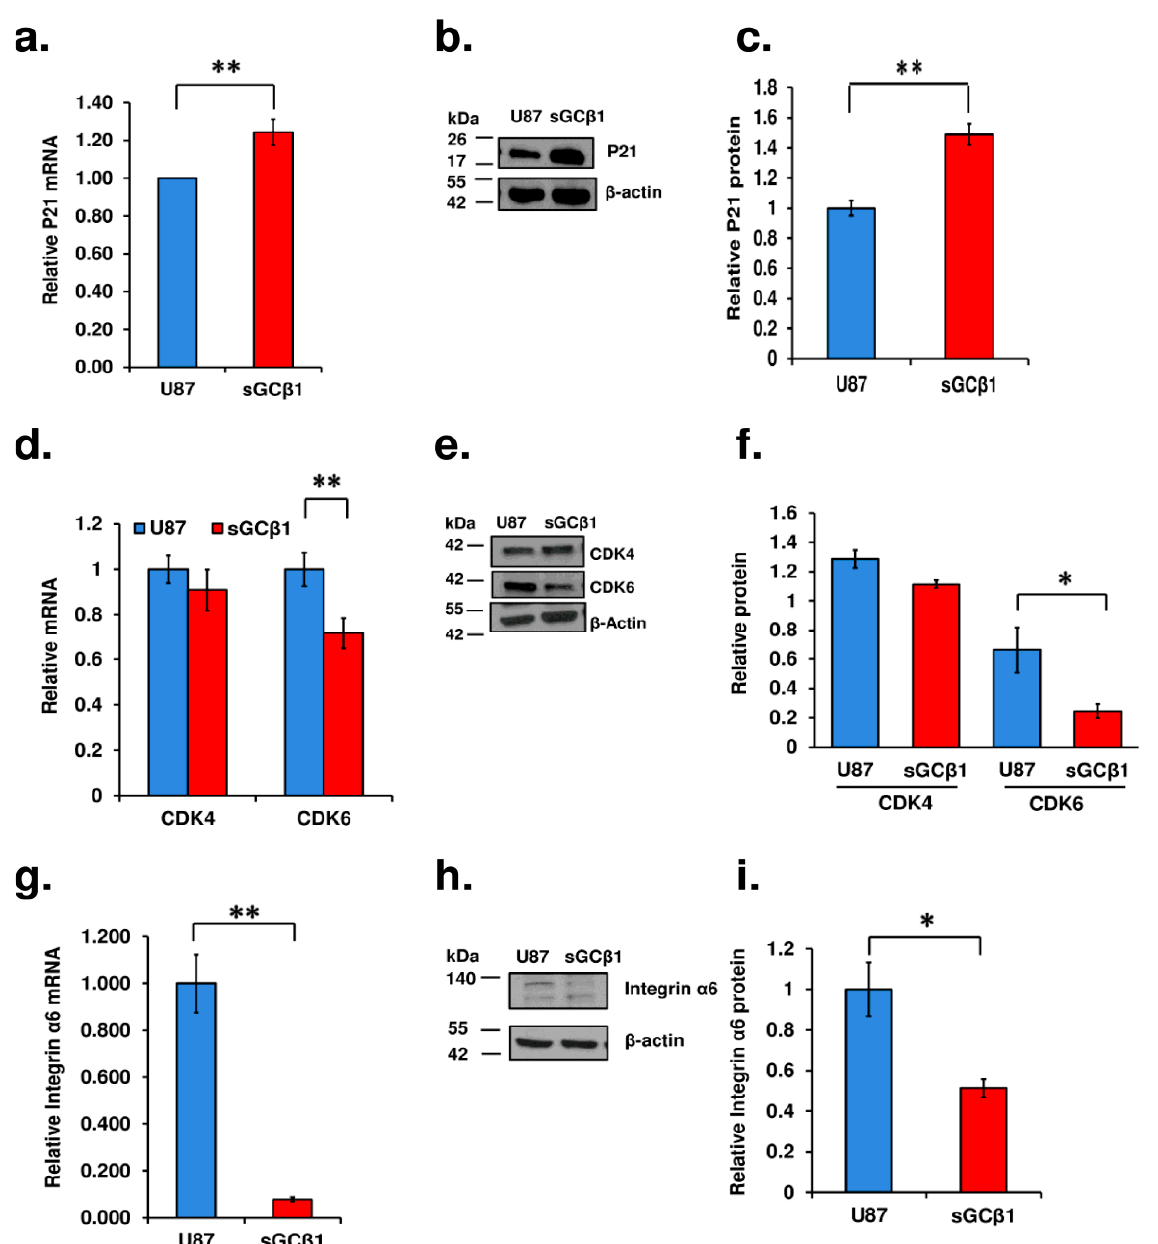
Figure 6. Effects of sGC β 1 overexpression on signaling in glioblastoma multiforme. qRT-PCR analysis of p21 ( a ), CDK4, CDK6 ( d ), and integrin α 6 ( g ) expression in sGC β 1-overexpressing cells. Western blot analysis of p21 ( b , c ), Original Western blot figure can be found in Supplementary File S1, CDK4, CDK6 ( e , f ), Original Western blot figure can be found in Supplementary File S1, and integrin α 6 ( h , i ) levels in sGC β 1-overexpressing cells in the whole cell extract, Original Western blot figure can be found in Supplementary File S1. The data were normalized to the level of β -actin. pcDNA3.1D-transfected cells were used as a control. The data are the mean ± S.E.M. *, p < 0.05; **, p < 0.01 (vs. empty vector or